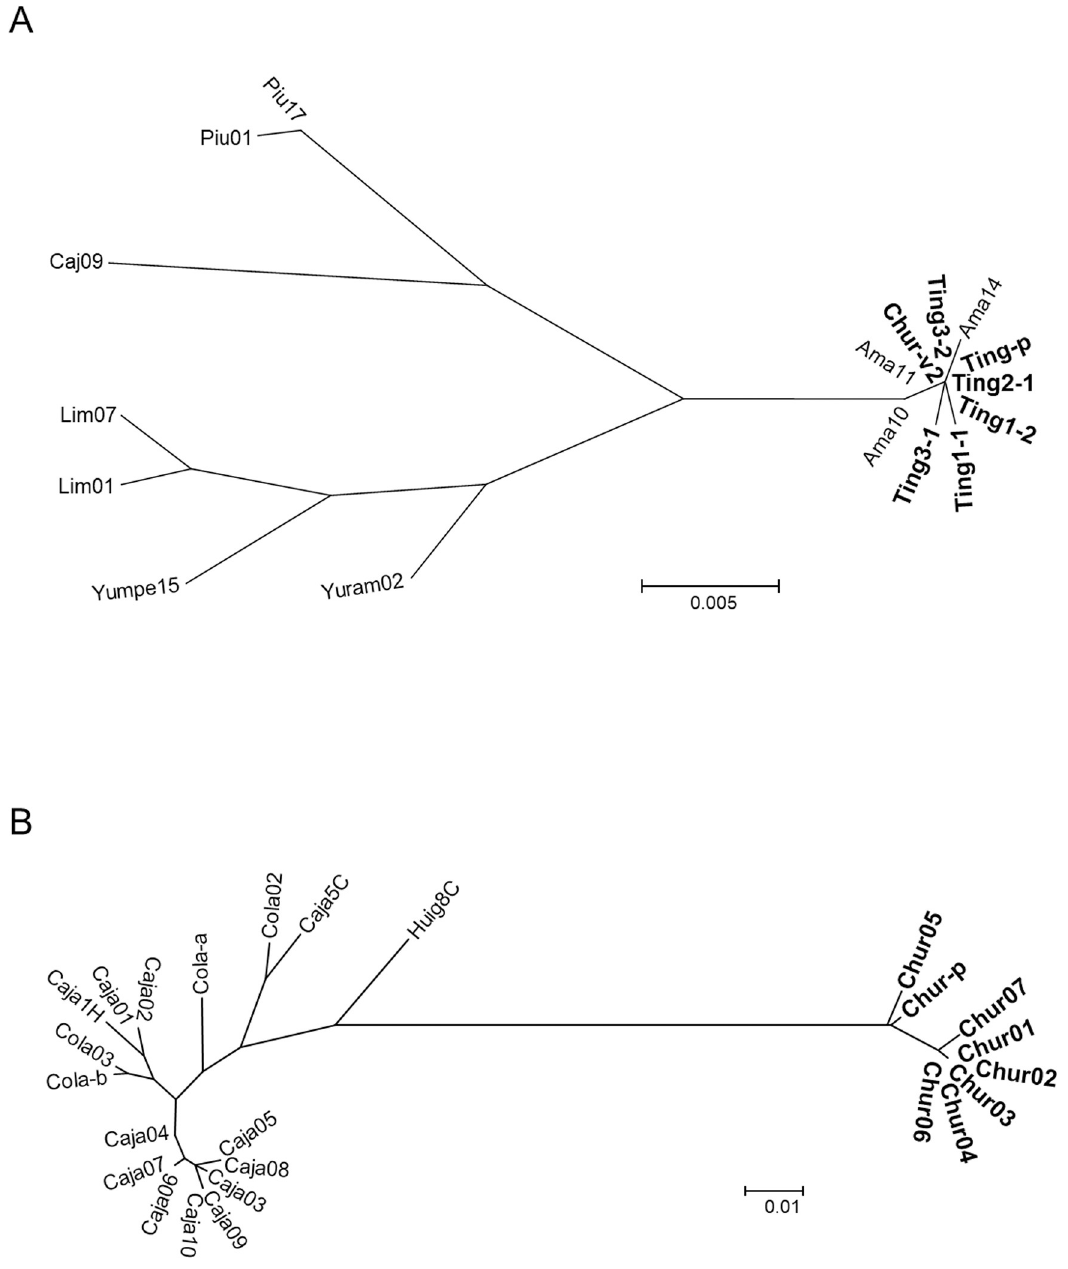
Fig 4. Phylogenetic analyses of cytochrome oxidase I (COI) gene sequences among Pi . verrucarum and among Pi . maranonensis . A. A phylogenetic analysis of the COI gene of Pi . verrucarum collected in this study (Ting1-1, Ting1-2, Ting2-1, Ting3-1, Ting3-2, Ting-p, and Chur-v2) was performed together with those from Departments of Amazonas (Ama10, Ama11, and Ama14), Piura (Piu01 and Piu17), Cajamarca (Caj09, Yuram02, and Yumpe15), and Lima (Lim01 and Lim07) in Peru. The scale bar represents 0.005% divergence. B. A phylogenetic analysis of the COI gene of Pi . maranonensis collected in this study (Chur01-Chur07 and Chur-p) was performed together with those from the Department of Cajamarca in Peru (Caja01-Caja10, Caja1H, Caja5C, Cola-a, Cola-b, Cola02, and Cola03) and the Province of Chimborazo in Ecuador (Huig8C). The scale bar represents 0.01%